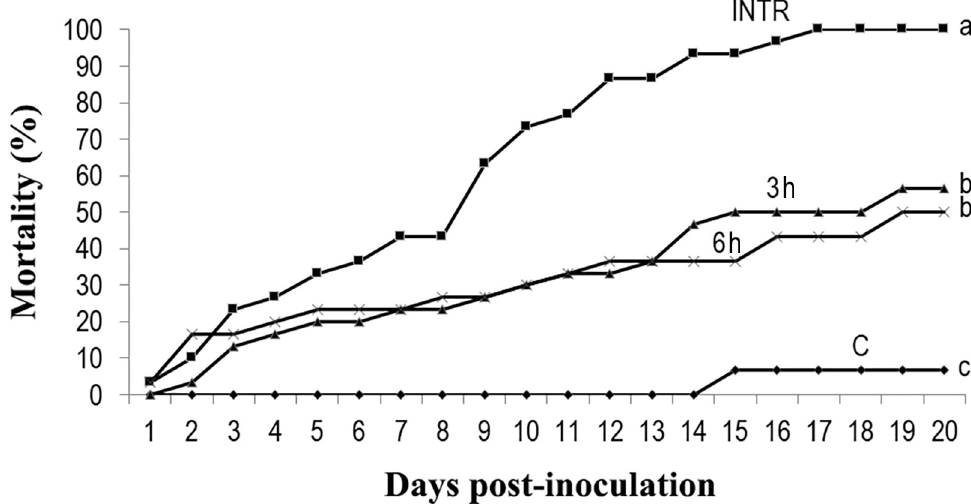
Fig 4. Impact of thermoregulation duration on mortality of infected locusts. The cumulative mortality of Locusta migratoria manilensis inoculated with Beauveria bassiana (10 4 spores/5 th instar nymph) following exposure to three regimes of thermoregulation (0 h, 3 h and 6 h per day are indicated by filled squares, triangles and Xs, respectively). The 0 h regime corresponded to inoculated non-thermoregulating locusts (INTR). C-non-infected, thermoregulating locusts are indicated by filled rhombuses. (n = 30 for three biological replicates). ANOVA on mortality on day 20 is followed by LSD (different letters indicate significant